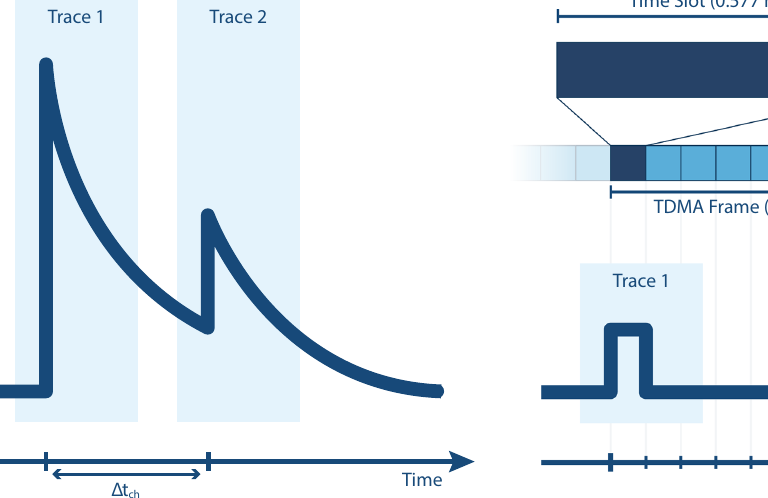
Fig. 3 Left: illustration of a pileup-on-tail outside the time window (POT) event. The pulse shape of Trace 2 is distorted by the tail of Trace 1. Two traces are saved with a timestamp difference Δ t ch . Right: